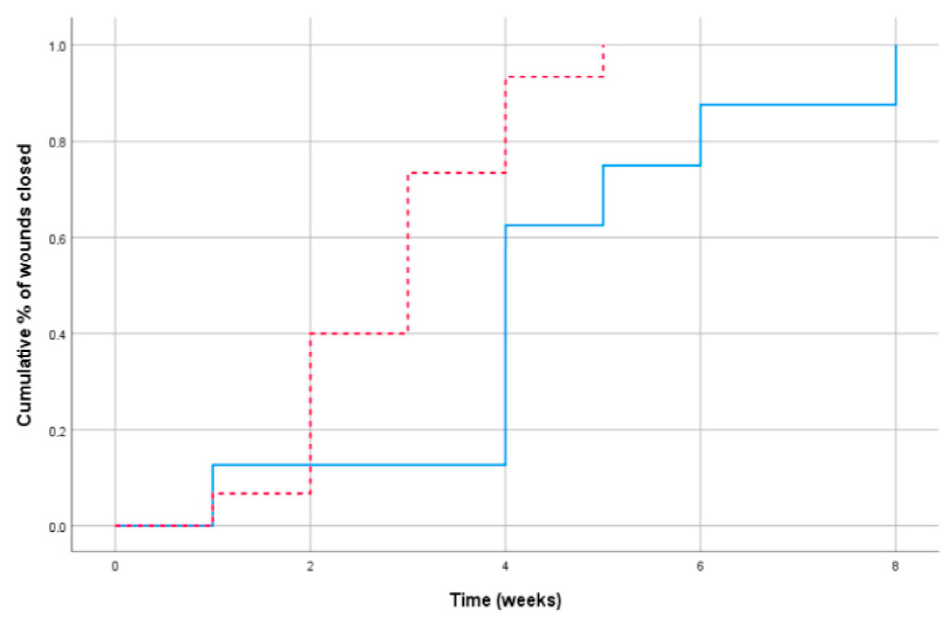
Figure 3. Cumulative percentage of wound closure by weeks: patients without breast cancer (dashed line) and patients with conservative treatment for breast cancer (solid line).